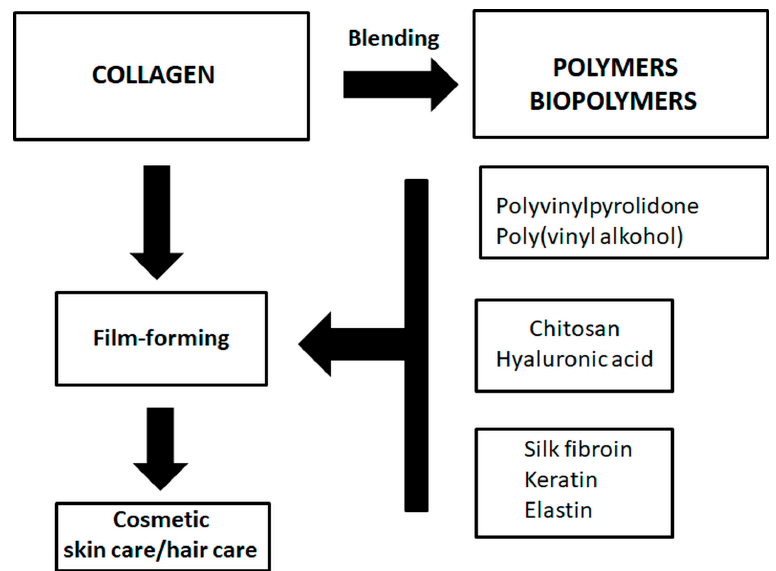
Figure 4. Polymers and biopolymers used for artificial blending with collagen.